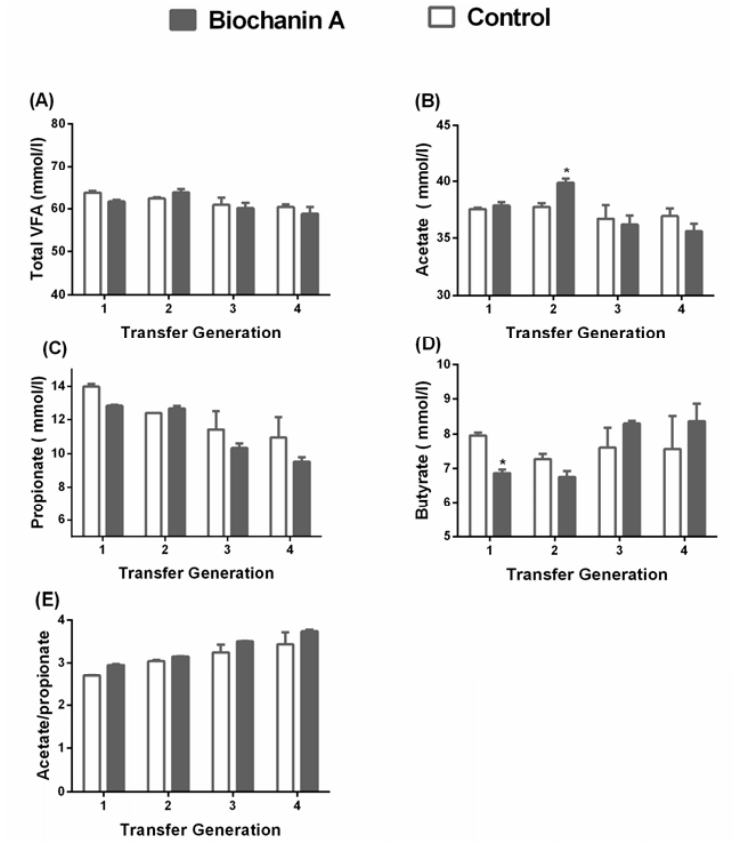
Figure 5. The effect of biochanin A on volatile fatty acid (VFA) production in anaerobic medium. Treatments included controls (only DMSO) and anaerobic medium with exogenous addition of biochanin A ( p > 0.05). Error bars represent SEM.